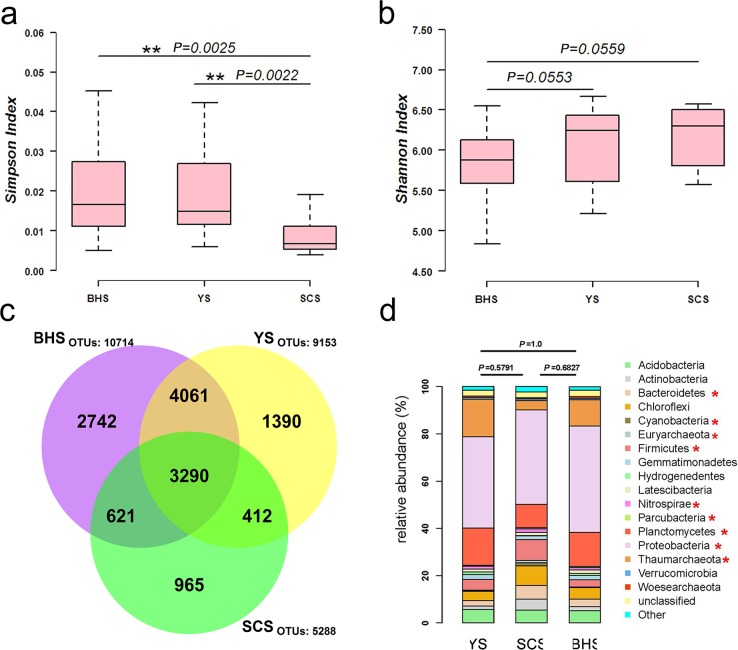
(a) Boxplot of Simpson indices calculated using the OTU data in the three sea areas. (b) Boxplot of Shannon indices calculated using the OTU data in the three sea areas. (c) Venn diagram denoting the number of unique and shared species in the different libraries at the 3% distance level. The yellow circle indicates the YS, the purple circle indicates the BHS, and the green circle indicates the SCS. (d) Diagram showing the relative abundance of bacterial composition in the three sea areas at the phylum level. The red star represents the specific bacterial taxa showing significant differences in one of the three groups.